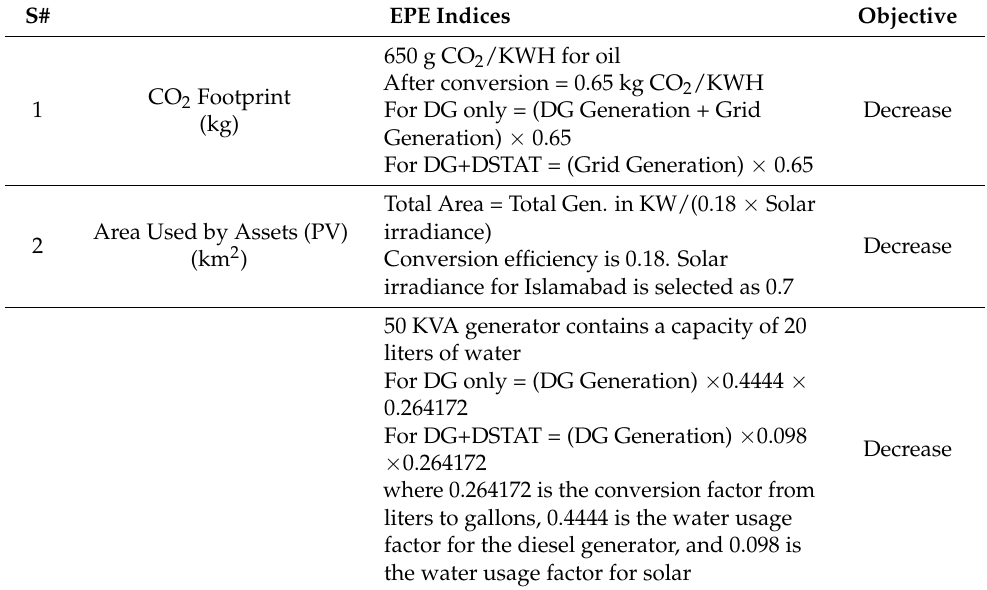
Table 5. Environment performance evaluation (EPE) indices [43,44].